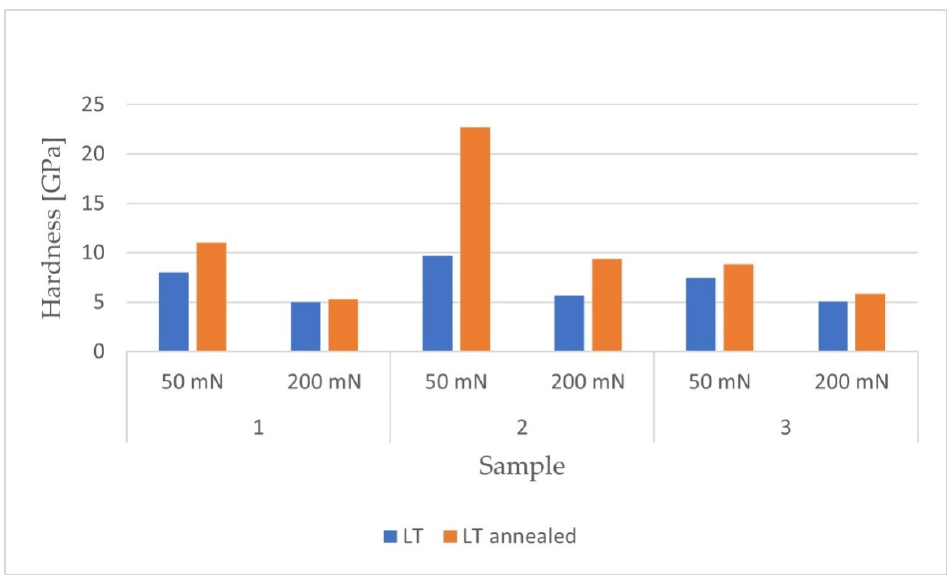
Figure 10. Results for hardness measurements for two maximum loadings: 50mN and 200 mN.